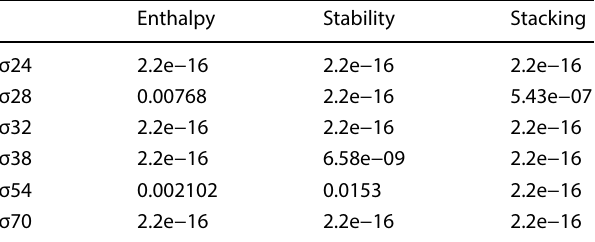
The values reflect the p values achieved by the Kruskal–Willis test of variance